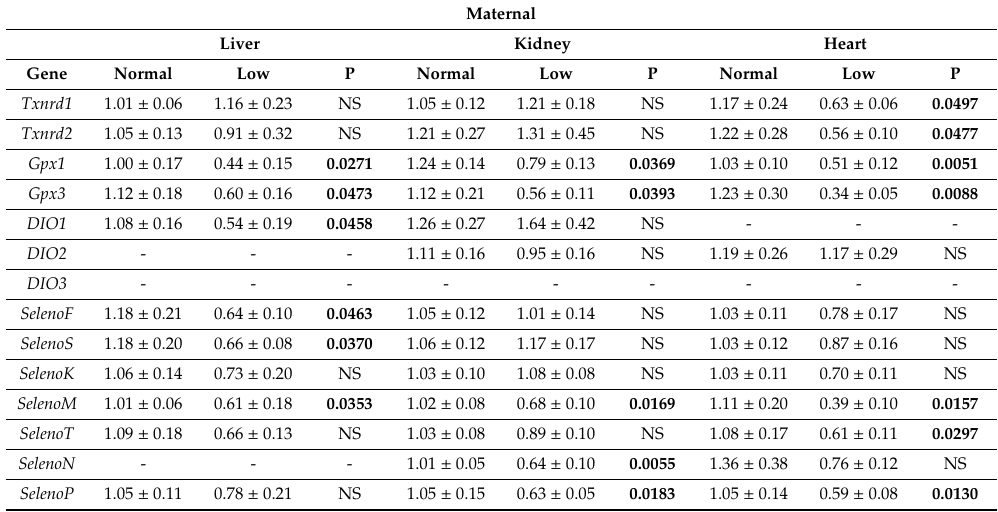
Table 3. E ff ects of selenium deficiency on selenoprotein expression in various maternal tissues.